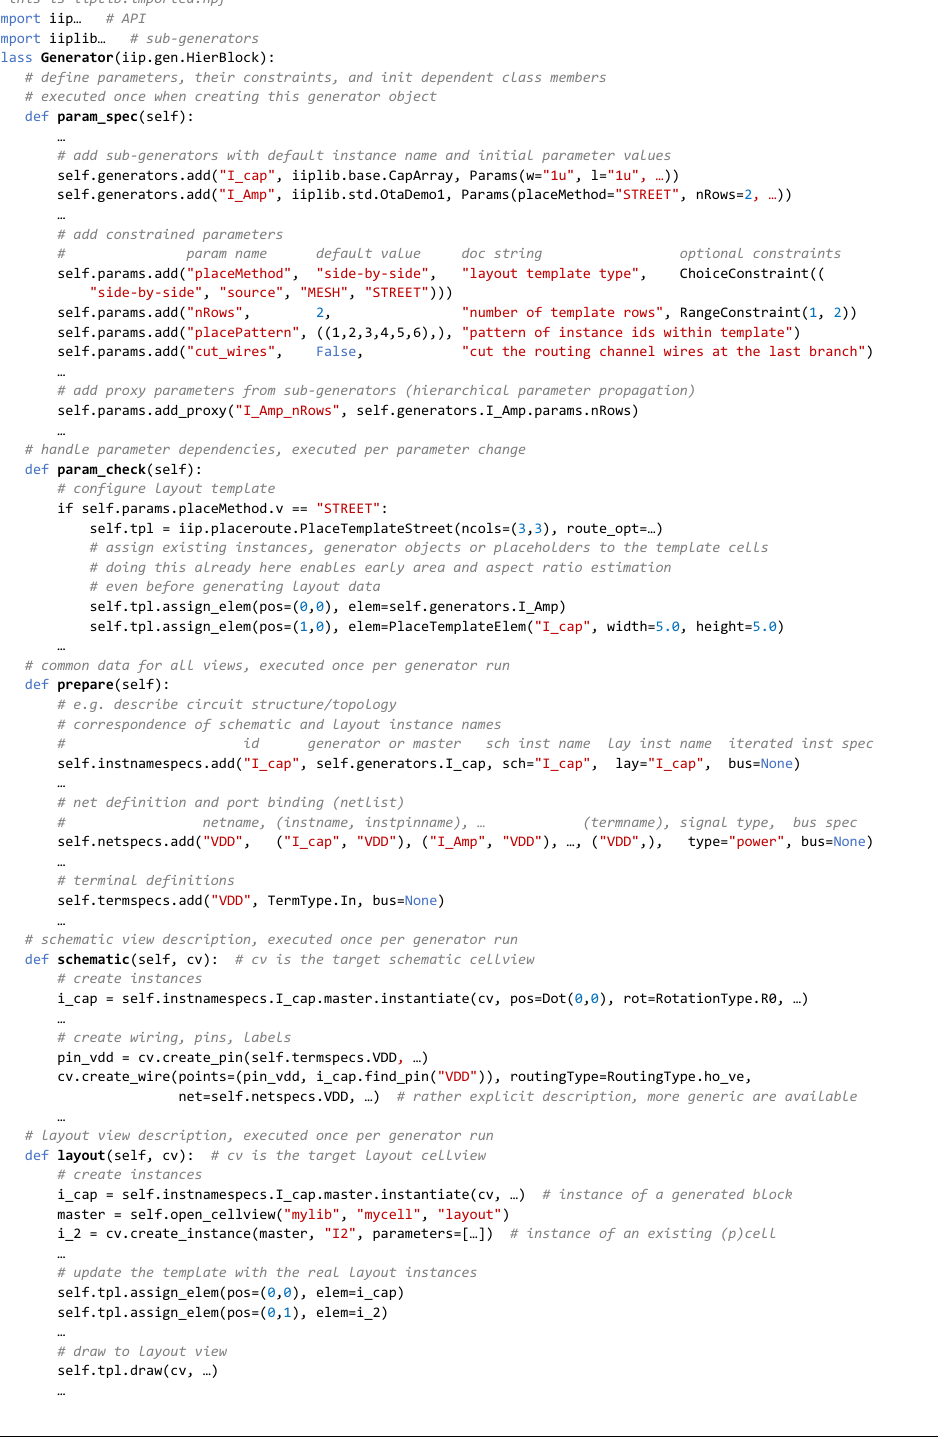
Figure A1. Representative and simplified selection of the generator code that was automatically created by the method presented in this work. Note that the template self.tpl connects parameter entries of the user (method param_check() ) with layout generation (method layout() ).